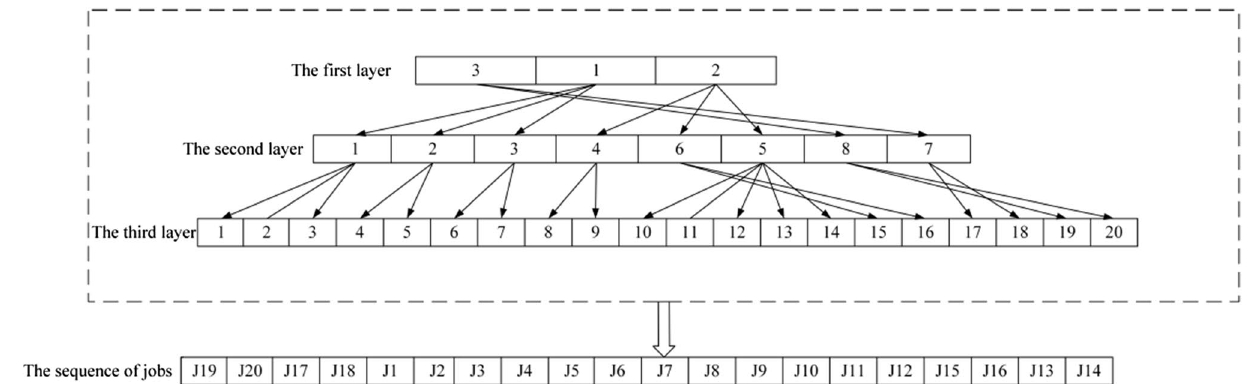
Fig. 3 Three-layer chromosome scheme